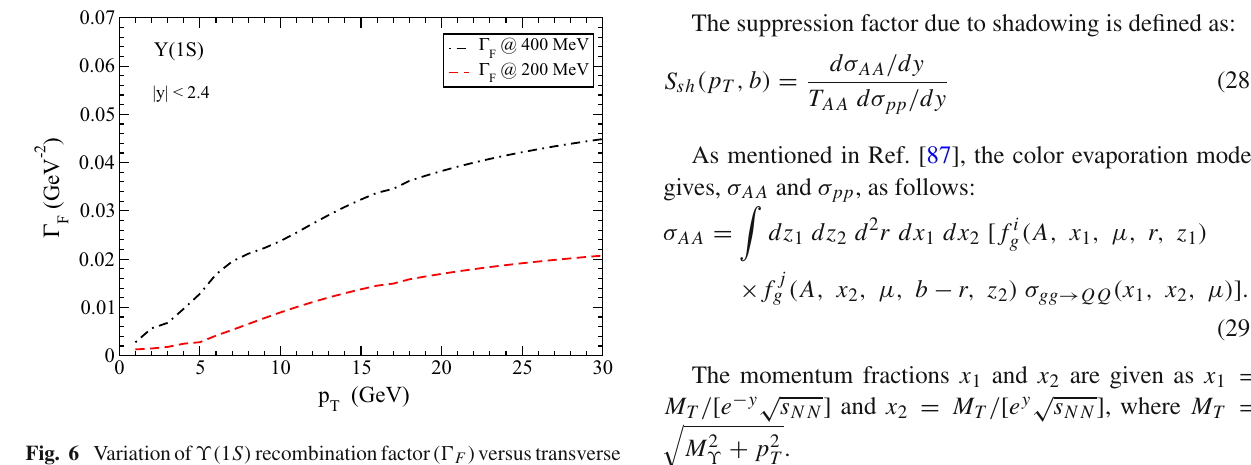
Fig. 6 Variationof ϒ( 1 S ) recombinationfactor( (cid:8) F )versustransverse momentum ( p T ) plotted for T ef f = 200 MeV and 400